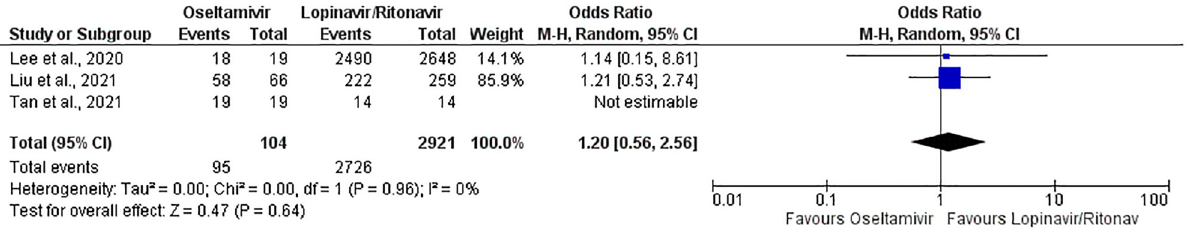
Fig 7. Forest plot. Shows the meta-analysis comparing the survival of the oseltamivir group to the Lopinavir/Ritonavir group.